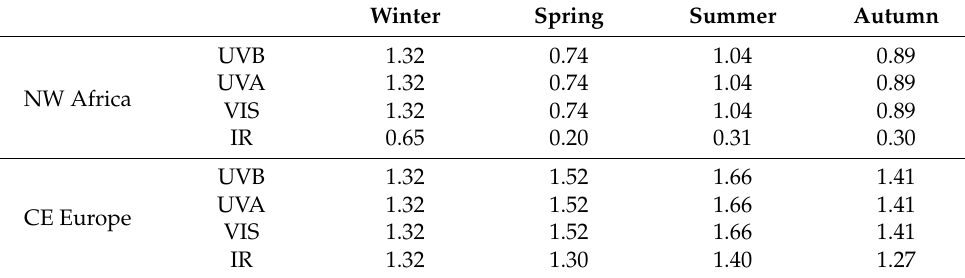
Table 4. AE used in the simulations for NW Africa and CE